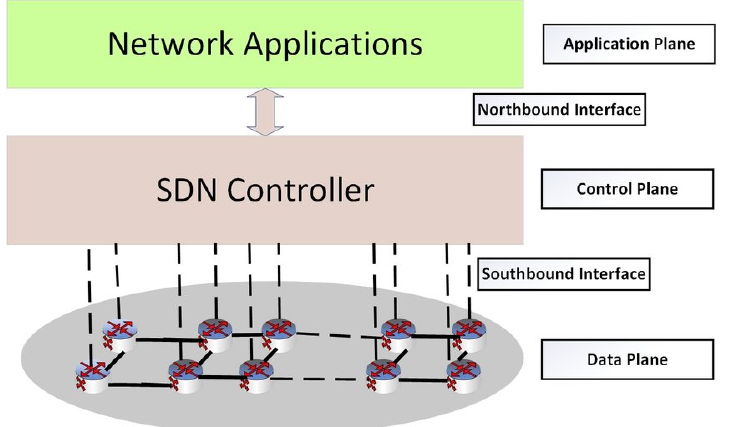
Figure 1. Software-defined network (SDN)